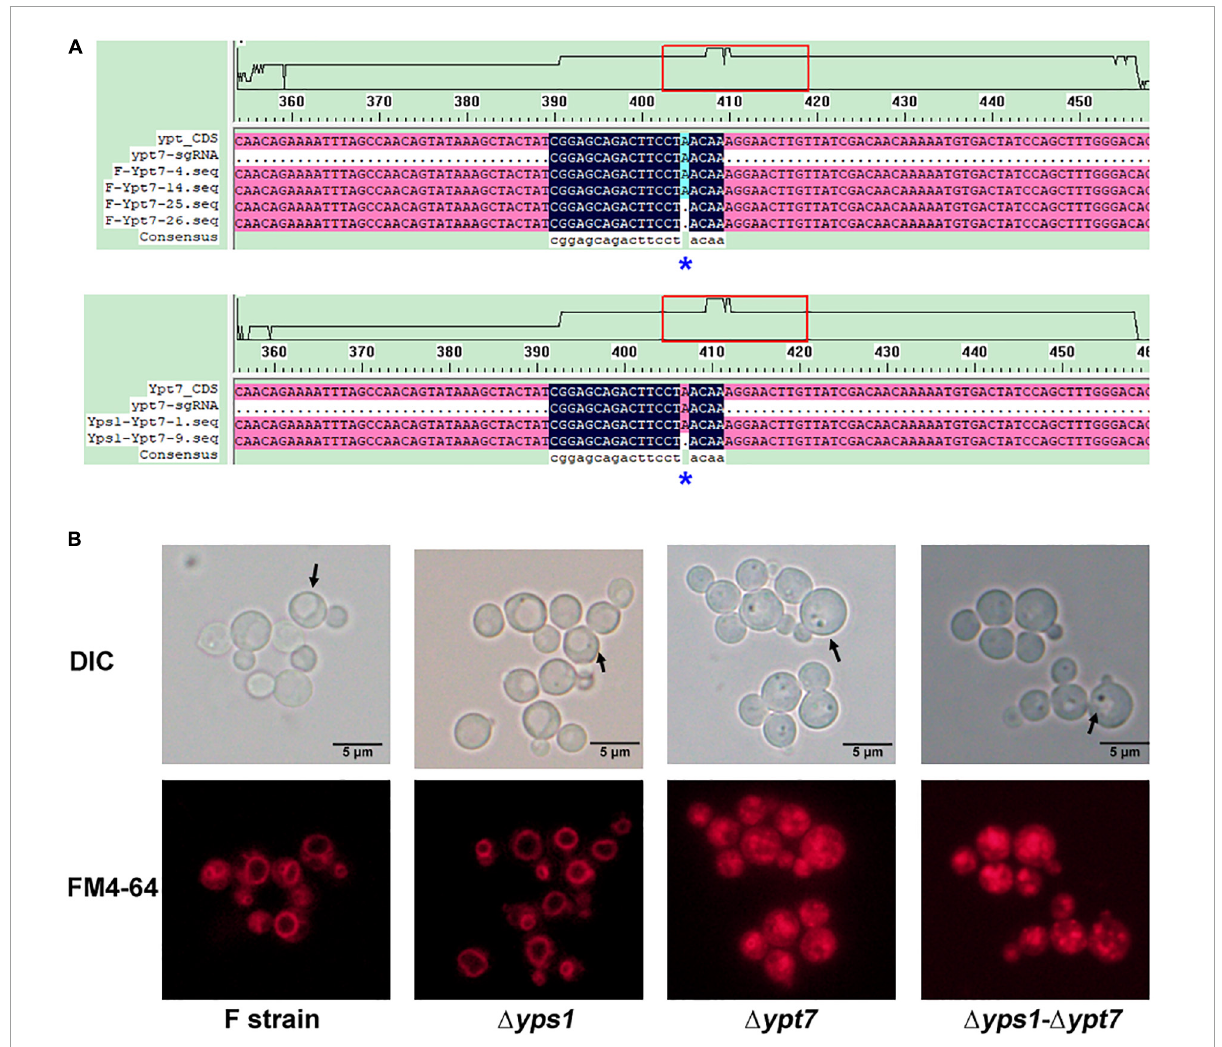
FIGURE5 Identification and phenotype of YPT7 -disrupted strains. (A) Knock out the YPT7 gene by CRISPR-Cas 9 in F (Upper) and (cid:49) yps1 (Lower) strains. (B) Vacuolar morphology in F and mutant strains. Upper, Nomarski optics; lower, FM4-64 fluorescence.